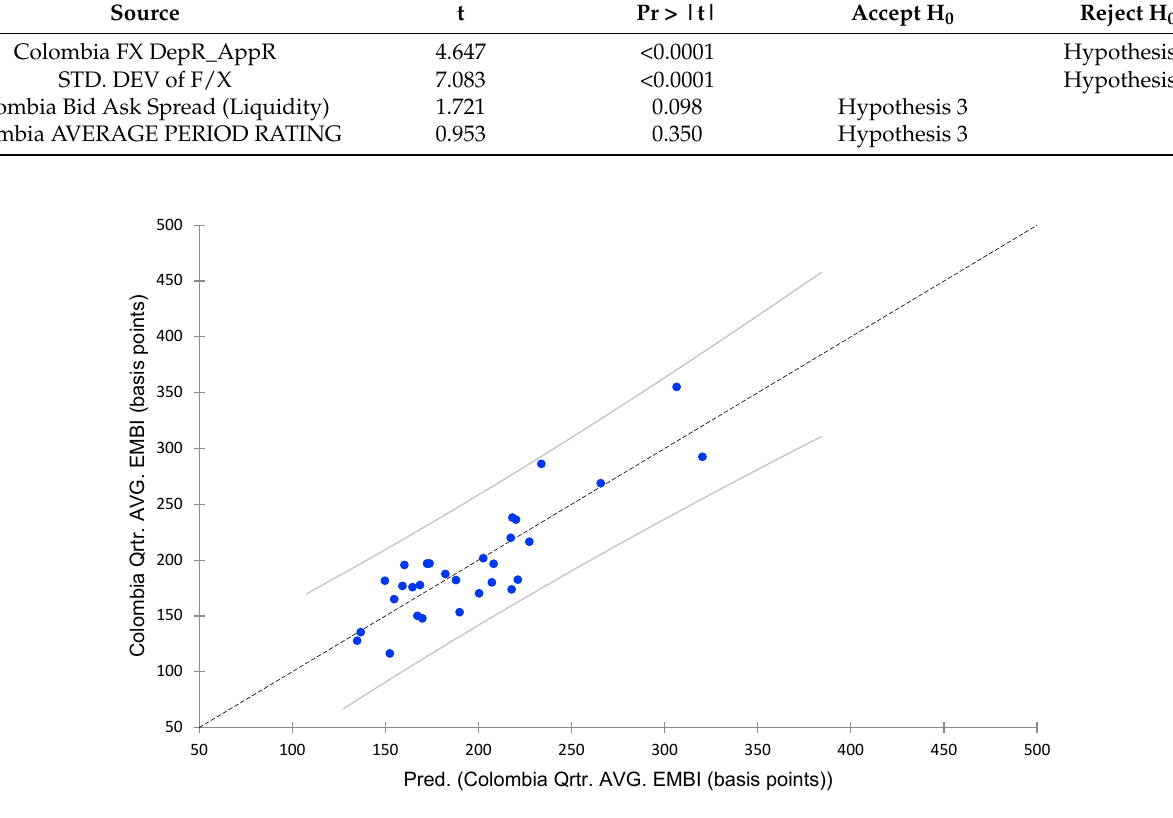
Figure 2. Colombia predicted vs. actual EMBI spread.